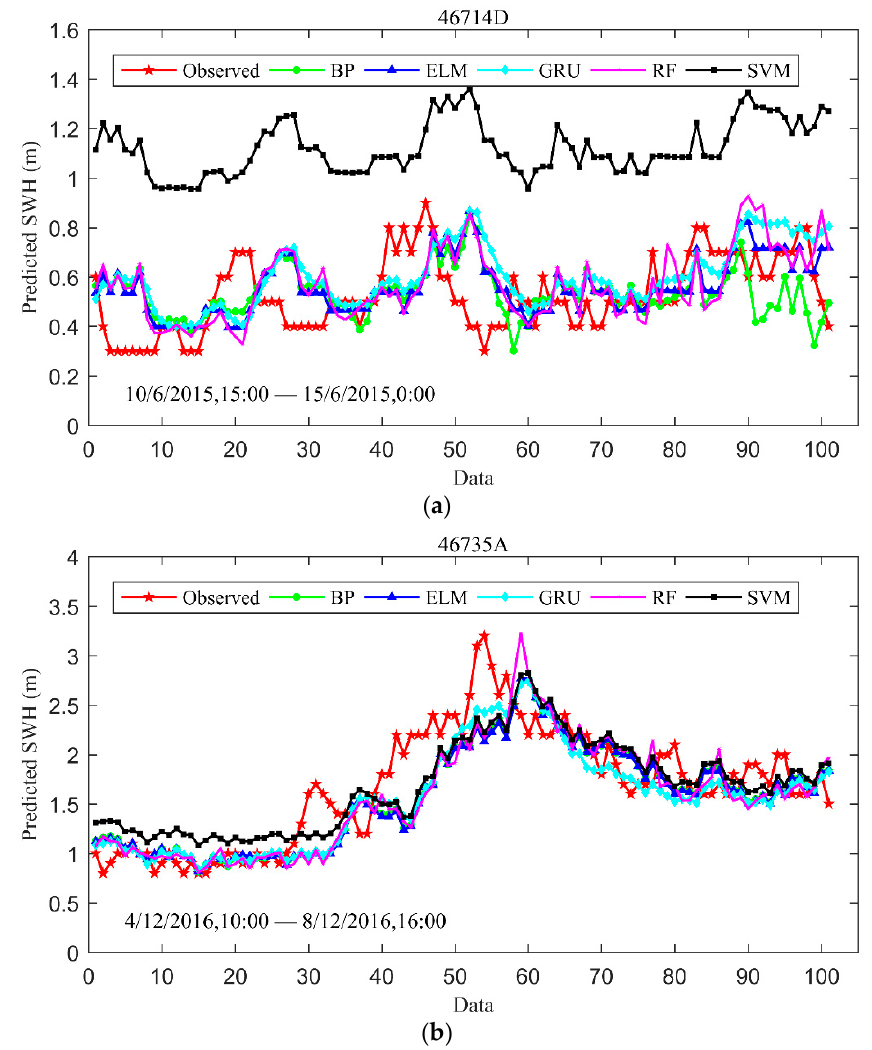
Figure 6 provides the comparison of the five different algorithms for the 6 h